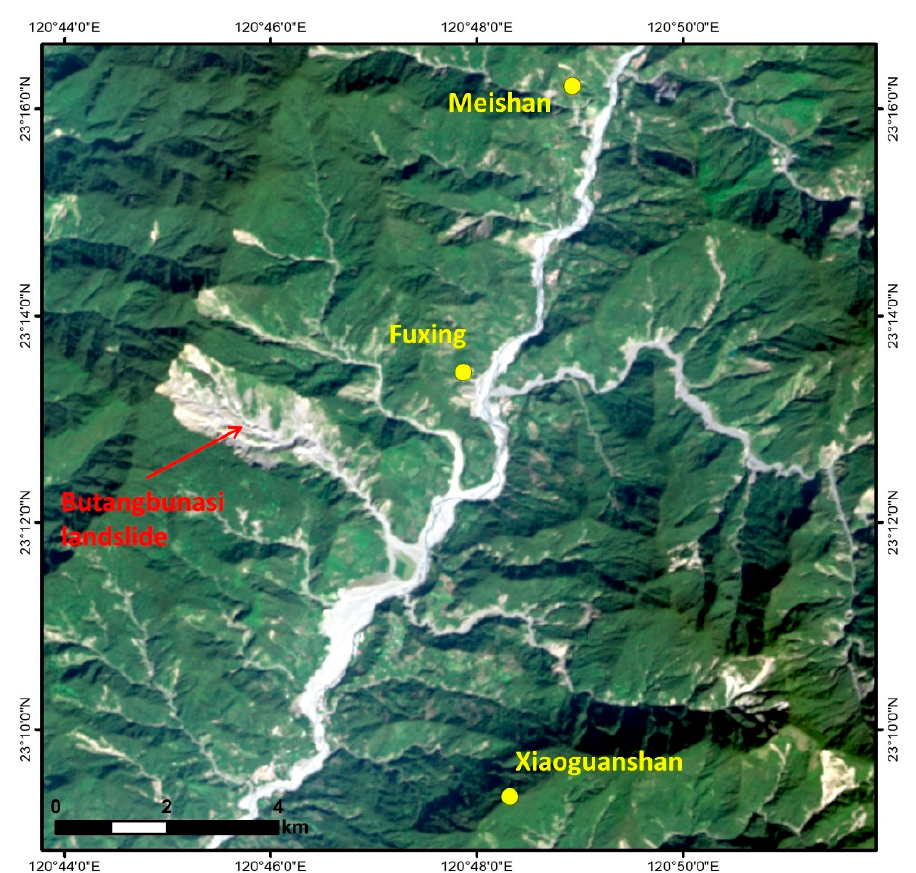
Figure 3. Locations of the three selected CWB rain gauge stations shown on the Landsat image